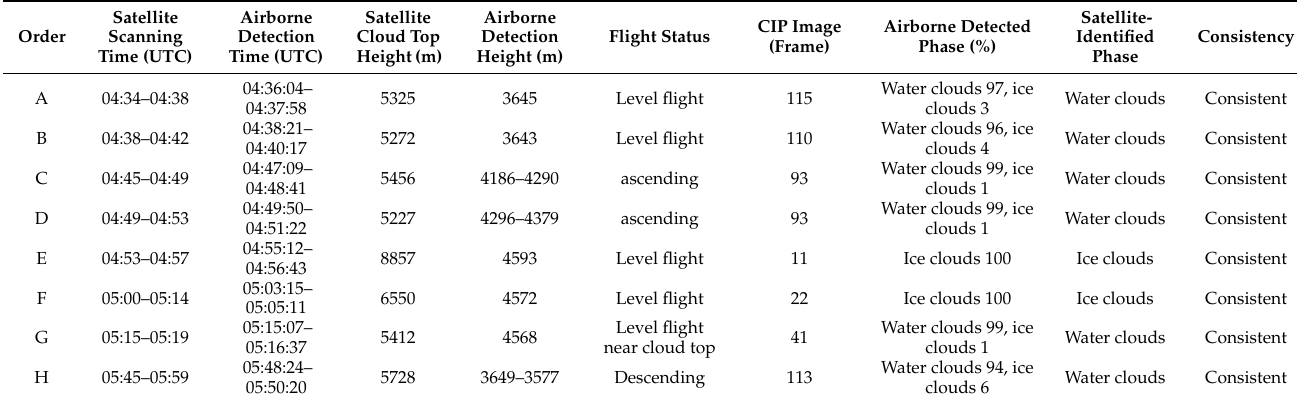
Table 4. FY-4A identified cloud phases validated against airborne